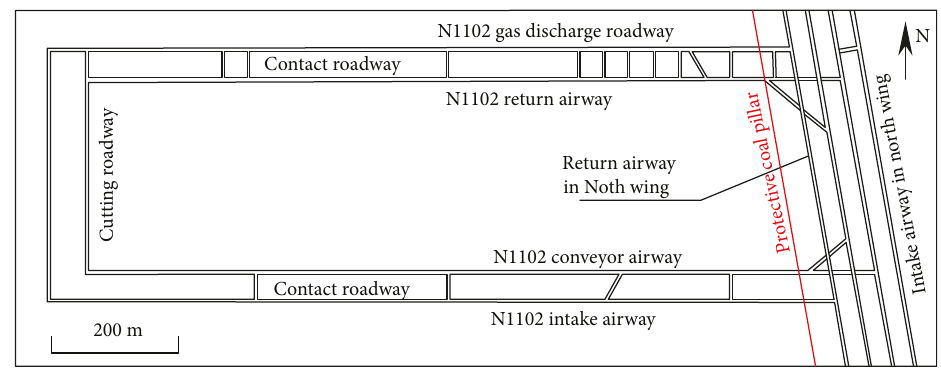
Figure 4: Schematic diagram of N1102 working face of Yuwu coal mine. Table 2: Overlying rock thickness and its mechanical parameters of N1102 working face.